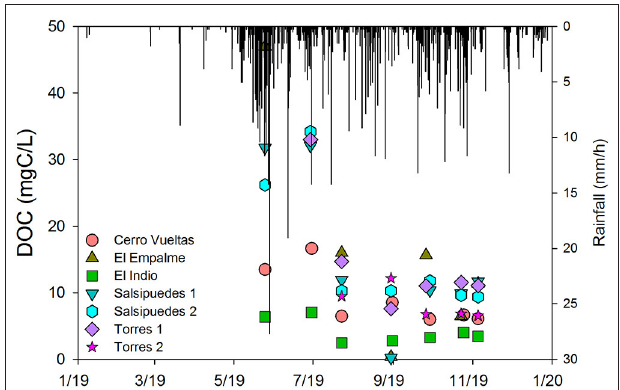
FIGURE 5 | DOC (mgC/L) temporal variation. Sampling sites are symbol and color-coded. El Empalme and El Indio represent the lowest and highest sampling sites, respectively (see Figure 1